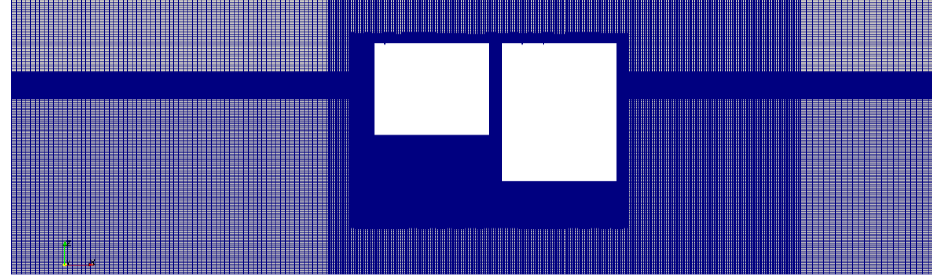
Figure 2. Mesh refinement of numerical water tank.